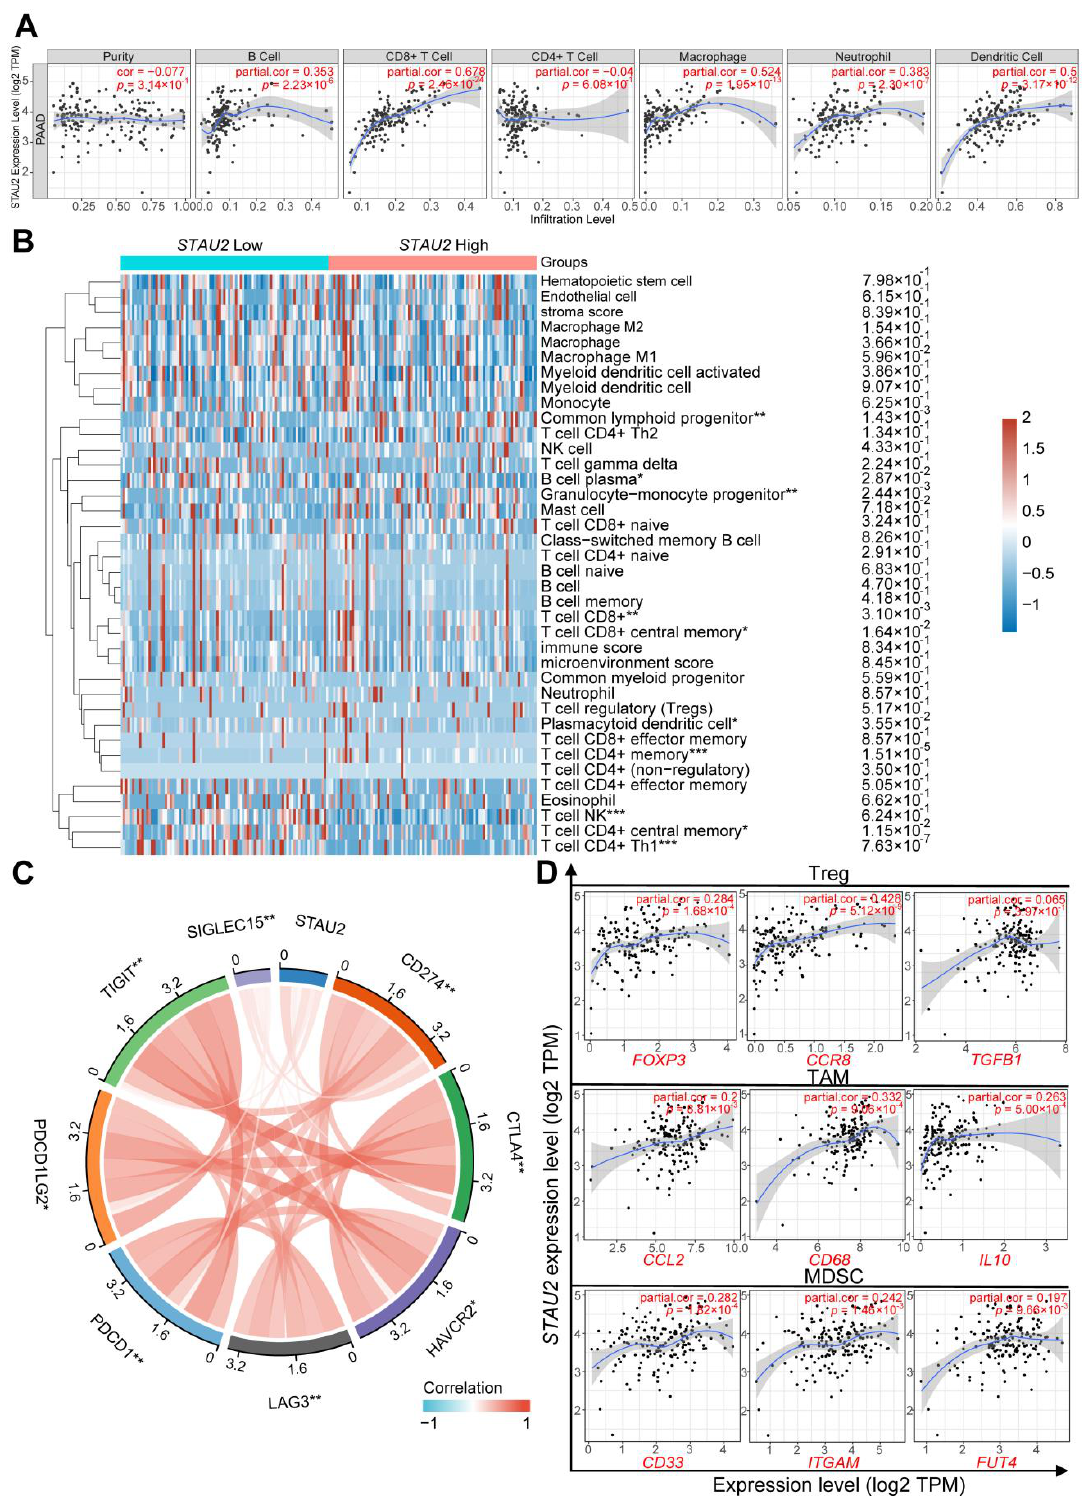
Figure 8. Correlation analysis of STAU2 expression with levels of immune infiltration and immune checkpoints in pancreatic adenocarcinoma ( A ) STAU2 positively correlates with infiltration of B cells, CD8+ T cells, macrophages, neutrophils, and dendritic cells by the TIMER. ( B ) Immune cells’ score heatmap associated with STAU2 expression. * p < 0.05, ** p < 0.01, *** p < 0.001. ( C ) Correlation analysis of STAU2 expression level and the level of eight immune control points in pancreatic cancer * p < 0.05, ** p < 0.01. ( D ) Correlation analysis of STAU2 and Treg, TAM, and MASC cell gene markers in TIMER.